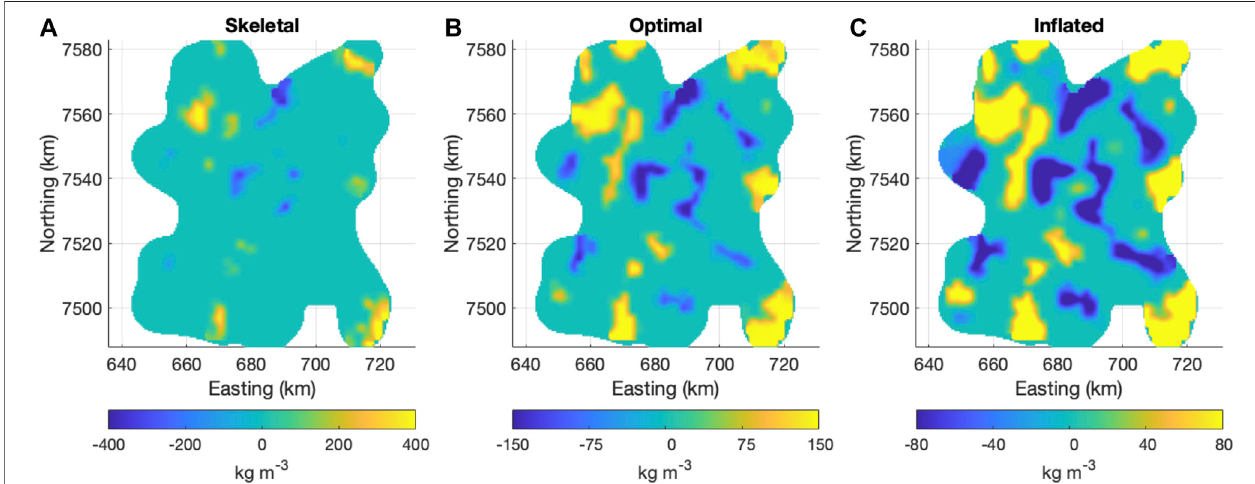
FIGURE 2 | Depth slices at sea level of skeletal, optimal, and in fl ated density models produced with GROWTH2.0. (A) Skeletal model produced with too large density contrast bounds ( ± 400 kg m − 3 ). (B) Optimal model produced with ± 150 kg m − 3 density contrast bounds (C) In fl ated model produced with too small density contrast bounds ( ± 80 kg m − 3 ).